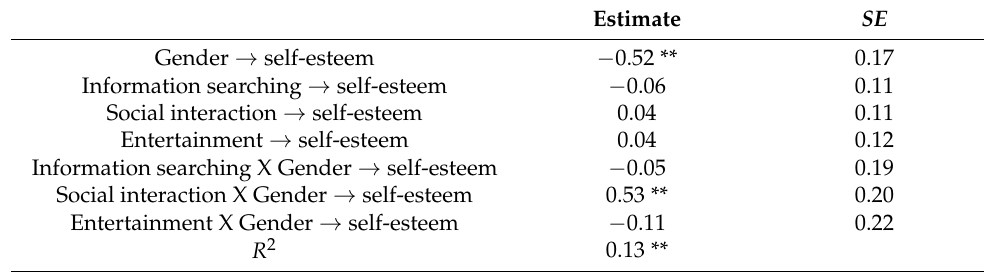
Table 4. Standardized coefficients of path analysis.